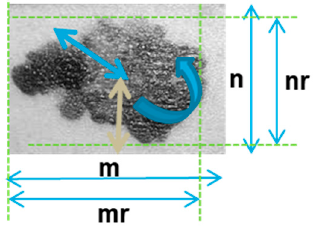
Figure 6. Graphical representation of the nevus image processing made by feature F 16.